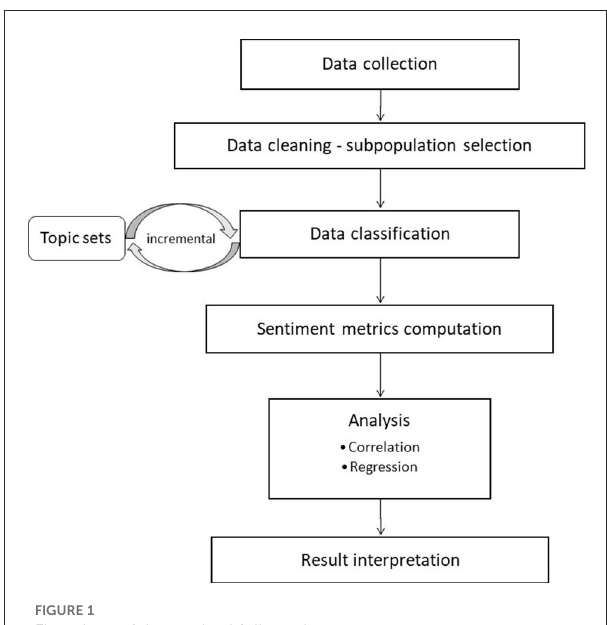
FIGURE1 Flowchart of the method